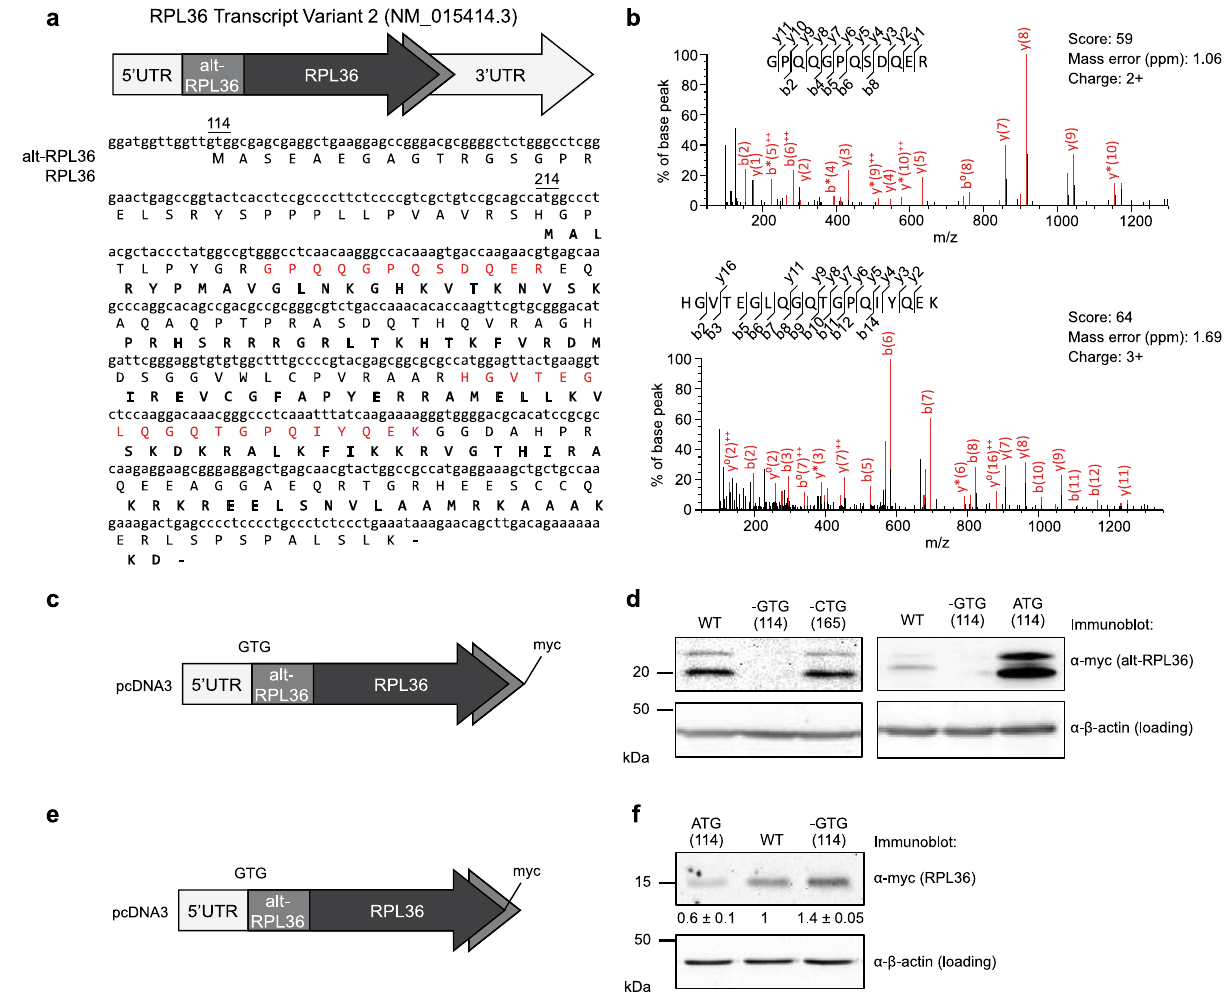
Fig. 1 A GUG-initiated alternative protein is translated from RPL36 transcript variant 2. a Top: a schematic representation of human RPL36 transcript variant 2 (tv 2); light gray arrow, 5 ′ and 3 ′ untranslated regions (UTR); mid gray, alternative open reading frame (alt-ORF) encoding alt-RPL36; dark gray, annotated RPL36 coding sequence. Bottom: the cDNA sequence of human RPL36 transcript variant 2 is shown with the protein sequences of alt-RPL36 and RPL36 (bold) indicated below. The GTG start codon of alt-RPL36 and ATG start codon of RPL36 are numbered above the cDNA sequence. Highlighted in red are two tryptic peptides of alt-RPL36 detected by LC-MS/MS. b MS/MS spectra of two alt-RPL36 tryptic peptides detected via peptidomics in HEK 293T cells. c , d Expression of a construct containing the full 5 ′ UTR and alt-RPL36 coding sequence derived from RPL36 tv 2, with a myc tag appended to the C-terminus of alt-RPL36 ( c ), in HEK 293T cells, was followed by lysis and western blotting with the antibodies indicated to the right ( d ). e , f Expression of a construct containing the full 5 ′ UTR and alt-RPL36 coding sequence derived from RPL36 tv 2, with a myc tag appended to the C-terminus of RPL36 ( e ), in HEK 293T cells, was followed by lysis and western blotting with the antibodies indicated to the right ( f ). Quantitative analysis of the western blot signal of RPL36-myc are indicated at the bottom. Data represent mean values ± standard error of the mean (s.e.m.) of three biological replicates. Source data are provided as a Source data fi le. All western blots are representative of results obtained in three biological